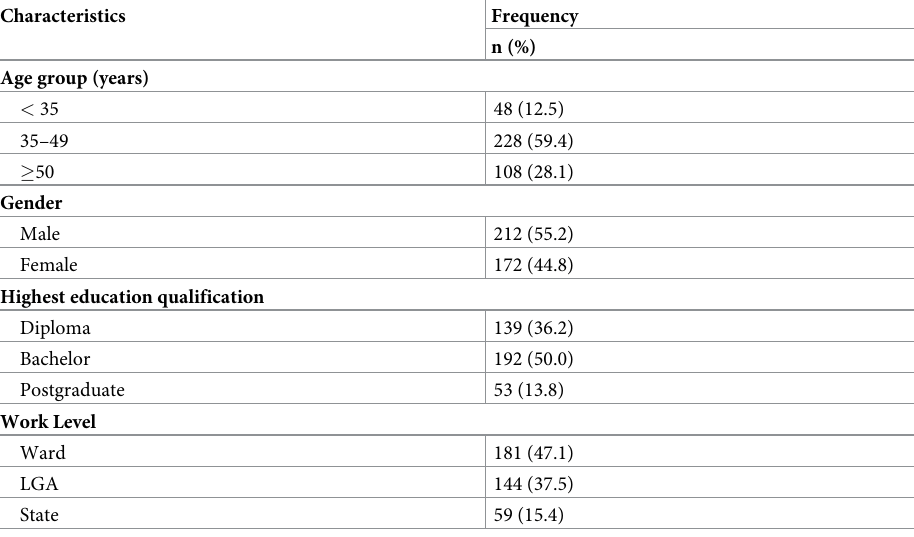
Table 1. Frequency distribution of the background characteristics of respondents (N =